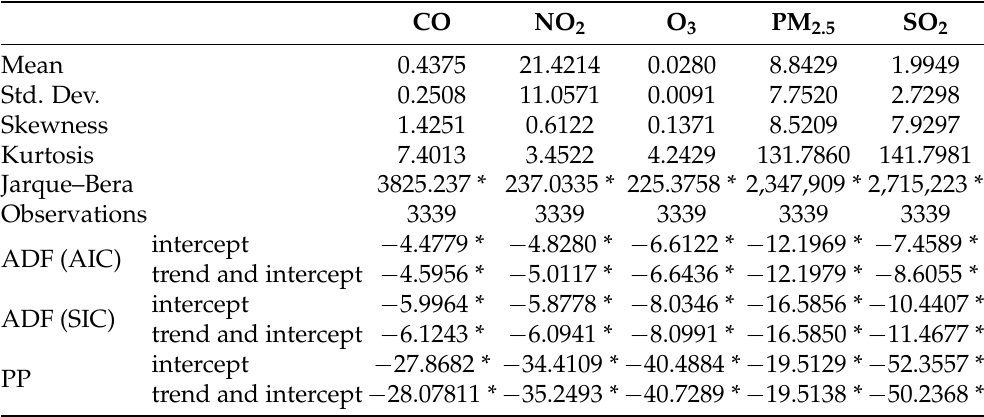
Table 3. Descriptive statistics: raw data